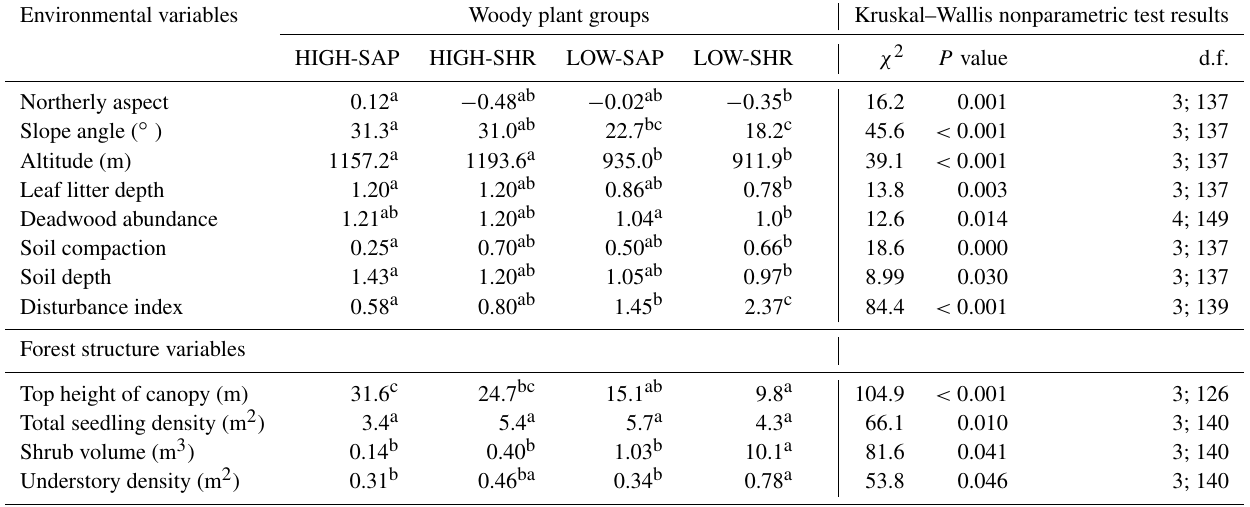
Table I1. Average values of selected environmental and forest structure variables for the four woody plant groups. Letters indicate groups that do not significantly differ within rows ( p < 0 . 05; Kruskal–Wallis nonparametric test). χ 2 is chi-square; d.f. is degrees of freedom (between-group degrees of freedom and within-group degrees of